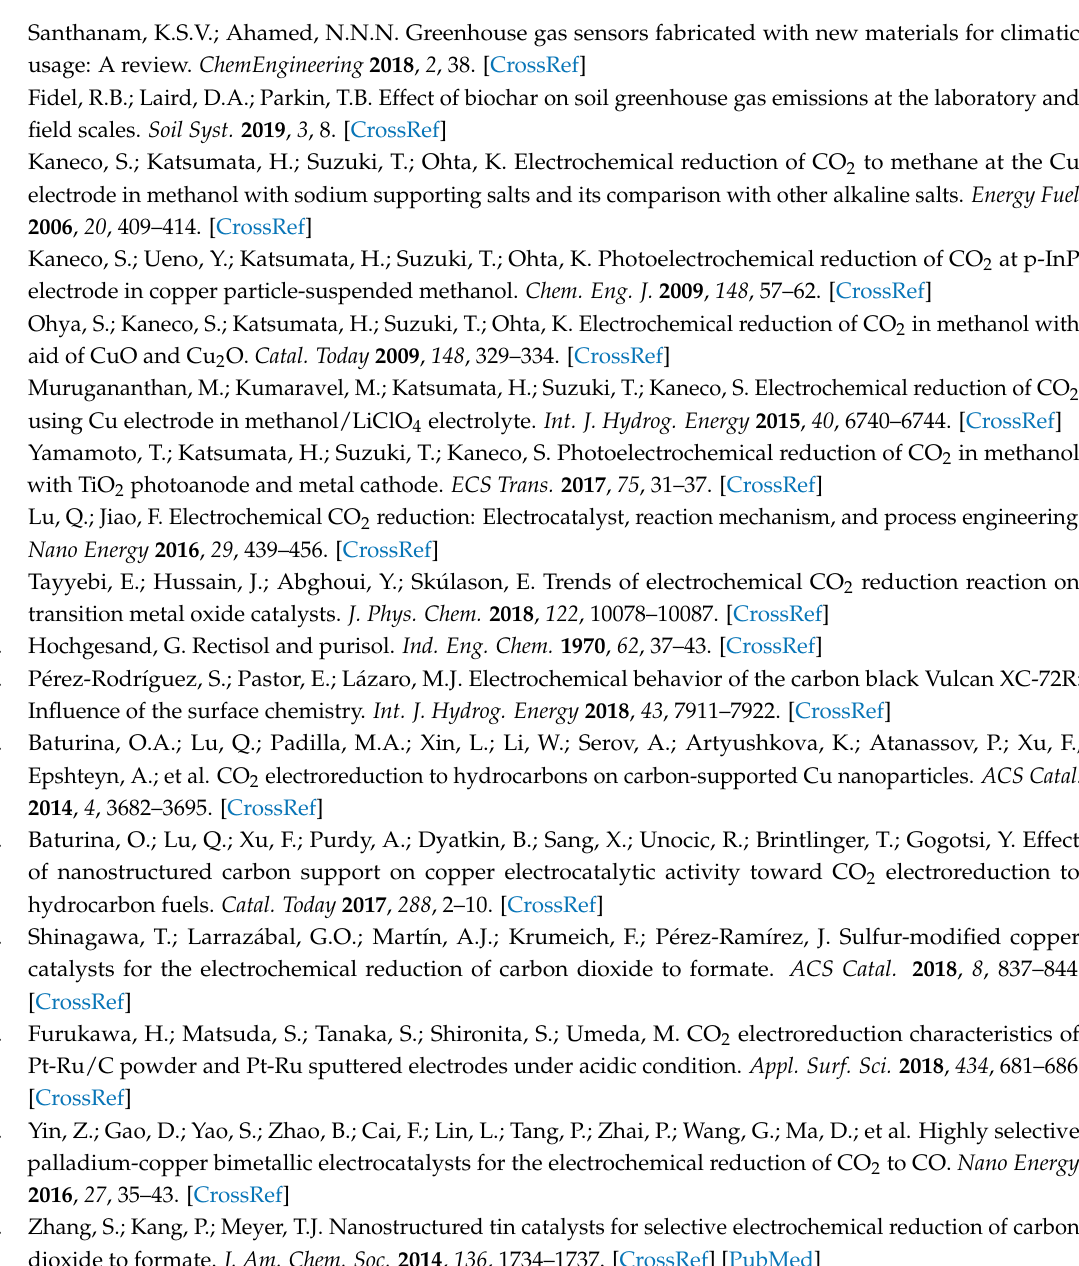
Apparatus and experimental conditions, Table S2: Effect of electrode on the Faradaic efficiencies of products by the electrochemical reduction of CO 2 , Table S3: Comparison of the present electrode with other electrodes that were reported